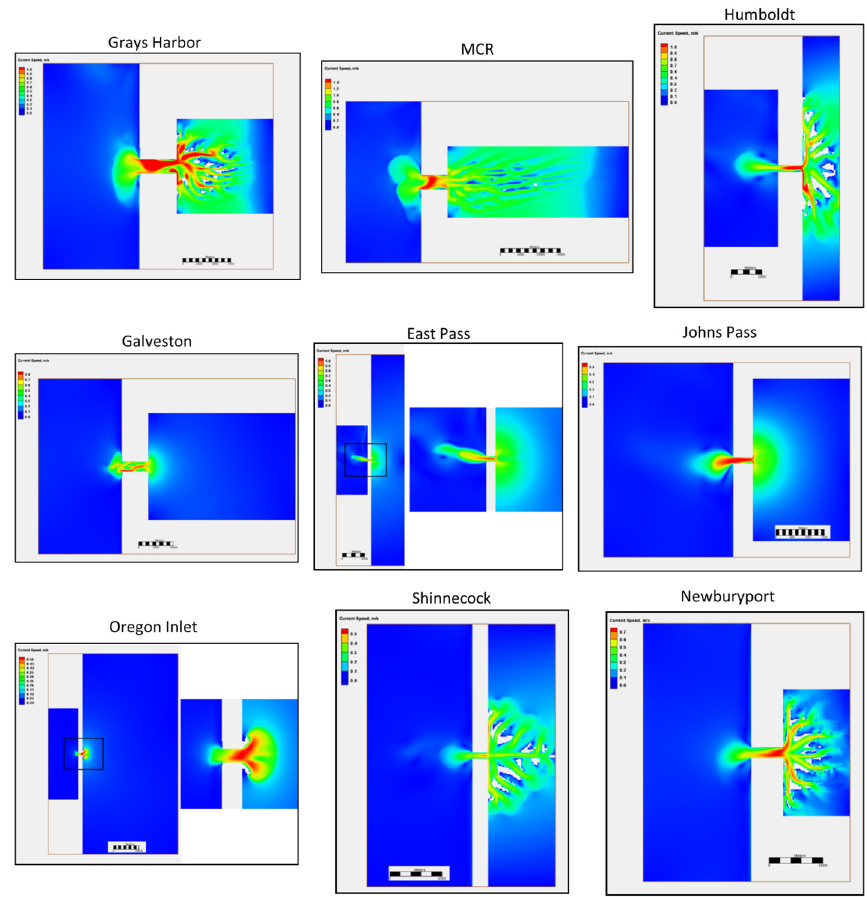
Figure 9. Maximum ebb currents near the end of the simulation. For clarity, the color scale varies between inlets. White areas shown inside the bays denote areas that were considered dry (above the water level) at the time chosen for the plot.